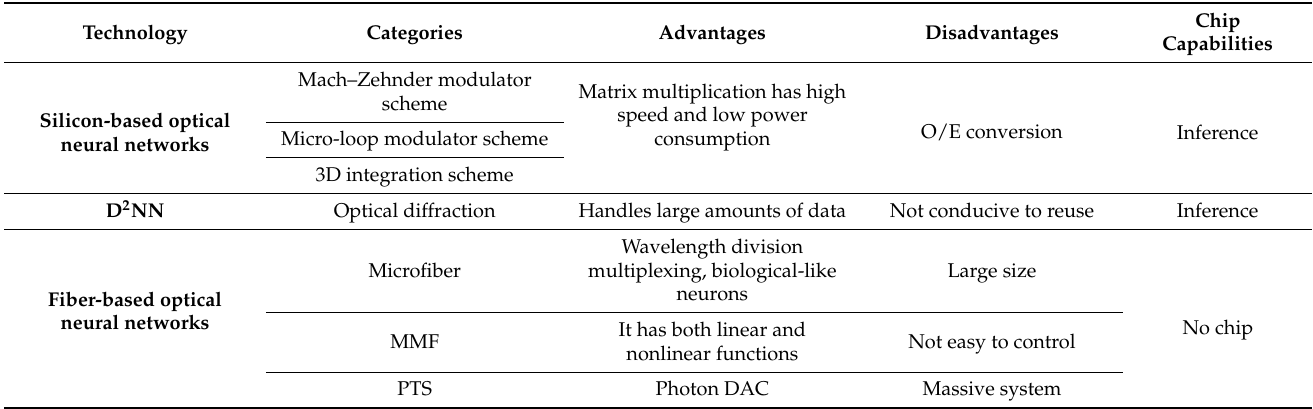
Table 1. Comparison of the different approaches to optical neural